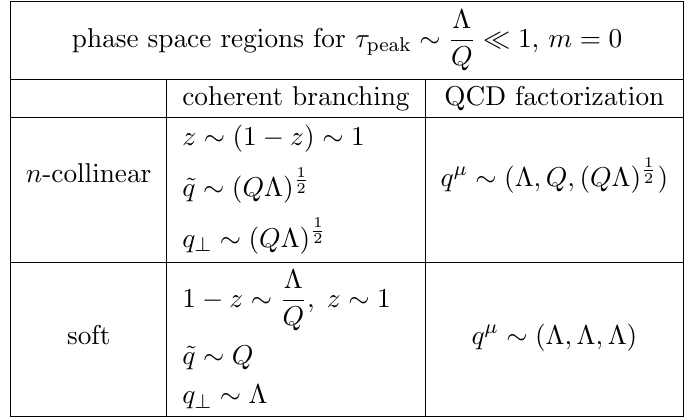
Table 1. Power counting for coherent branching and QCD factorization for masseless quarks. in the light cone basis